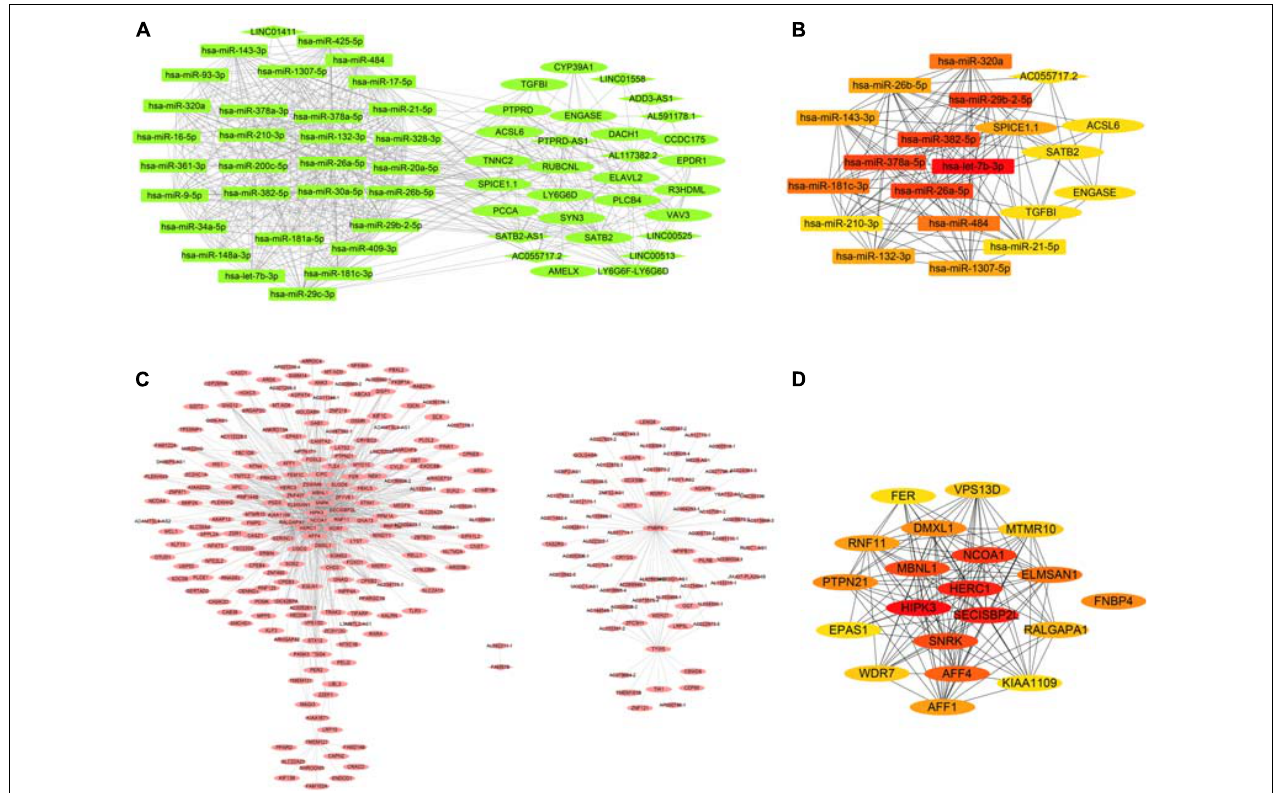
FIGURE 6 | Coexpression network and hub gene network. (A) The significant gene coexpression network of colon cancer, rectosigmoid junction cancer, and rectal cancer in the dark green module. (B) The most significant hub gene network generated by CytoHubba from the dark green module. (C) The significant gene coexpression network of esophageal cancer and gastric cancer in the brown module, which has 1027 edges and 279 nodes. (D) The most significant hub gene network generated by CytoHubba from the brown